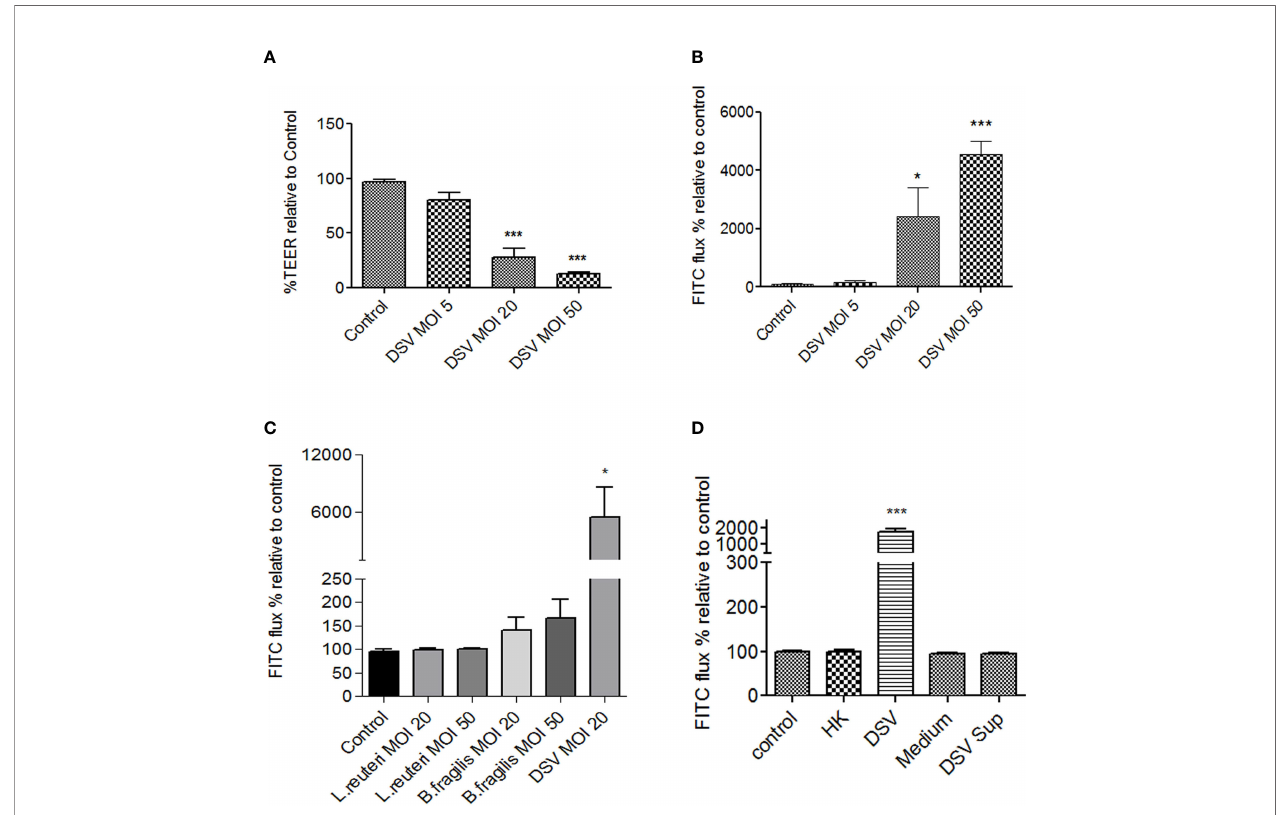
FIGURE 1 | DSV decreased TEER and increased permeability in polarized Caco-2 cells. Polarized Caco-2 cells were treated with DSV with various MOIs for 24 hours. (A) TEER was measured using EVOM ohmmeter by inserting electrodes into the trans-wells. (B) Cells were incubated for 1hr with 40 m l 4kDa FITC-Dextran (25mg/ml) added to the apical surface. After 1 hr. 100 m l of the medium from basolateral side was removed and analyzed for FITC fl uorescence, using excitation and emission at 485nm and 520nm, respectively. (C) FITC-Dextran fl ux was monitored in cells infected with L.reuteri , B.fragilis , or DSV for 24 with different MOIs. (D) FITC-dextran fl ux in cells were infected with live, heat killed (HK), bacterial Postgate ’ s culture medium alone, or with fi ltered culture supernatant of live DSV bacteria. Graph in all panels represent Mean ± SEM from at least 3 independent experiments. *p<0.05,